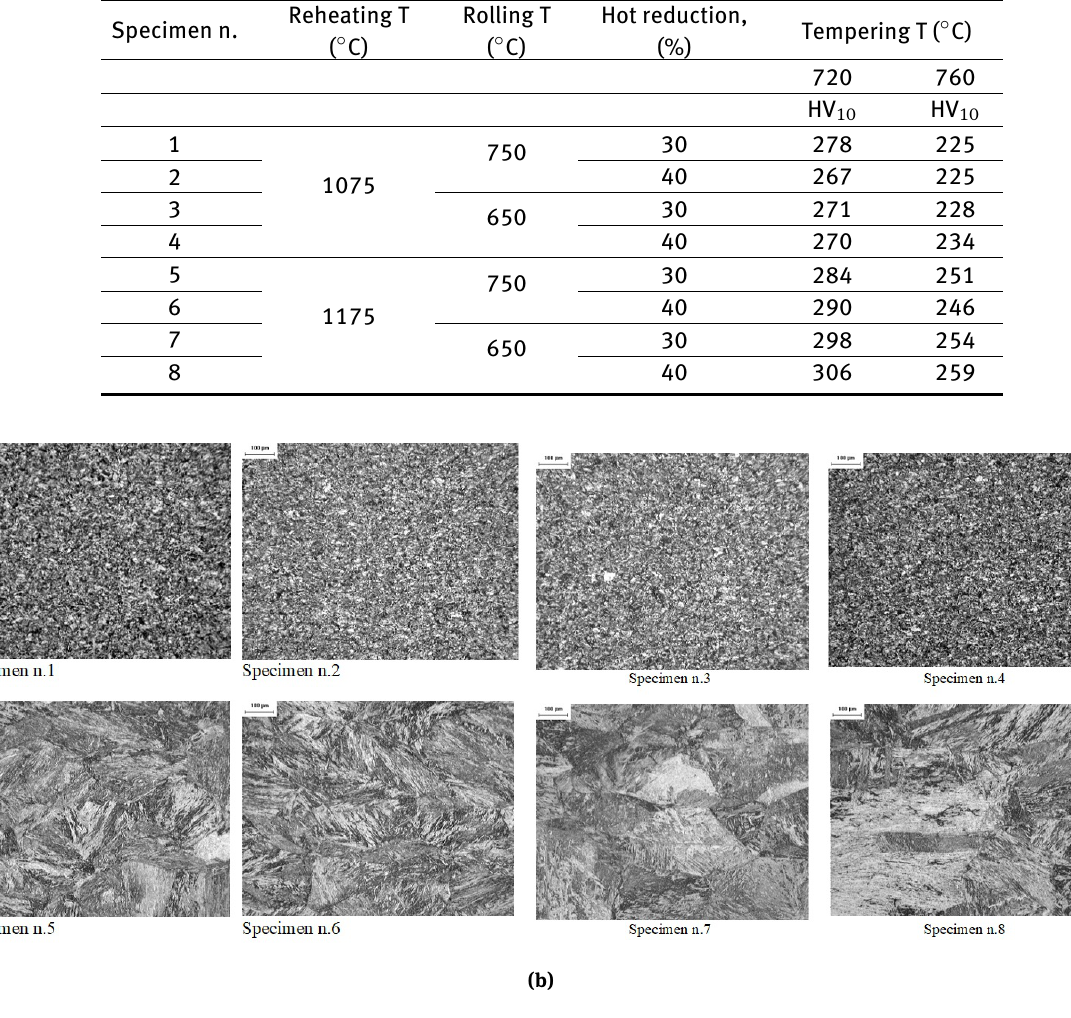
Figure 2: (a) Microstructure evolution of EUROFER 97 after thermo-mechanical processing according to Table 2 (Final rolling tempera- ture = 750 ∘ C; (b)Microstructure evolution of EUROFER 97 after thermo-mechanical processing according to Table 2 (Final rolling tempera- ture = 650 ∘